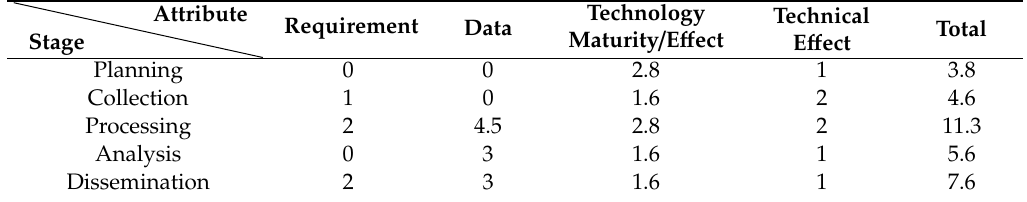
Table 7. Priority-determination result for system development